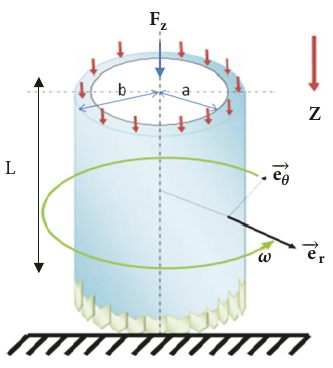
Figure 1: A drilling device made of FGM subjected to the action of a uniform axial load 𝐹 𝑧